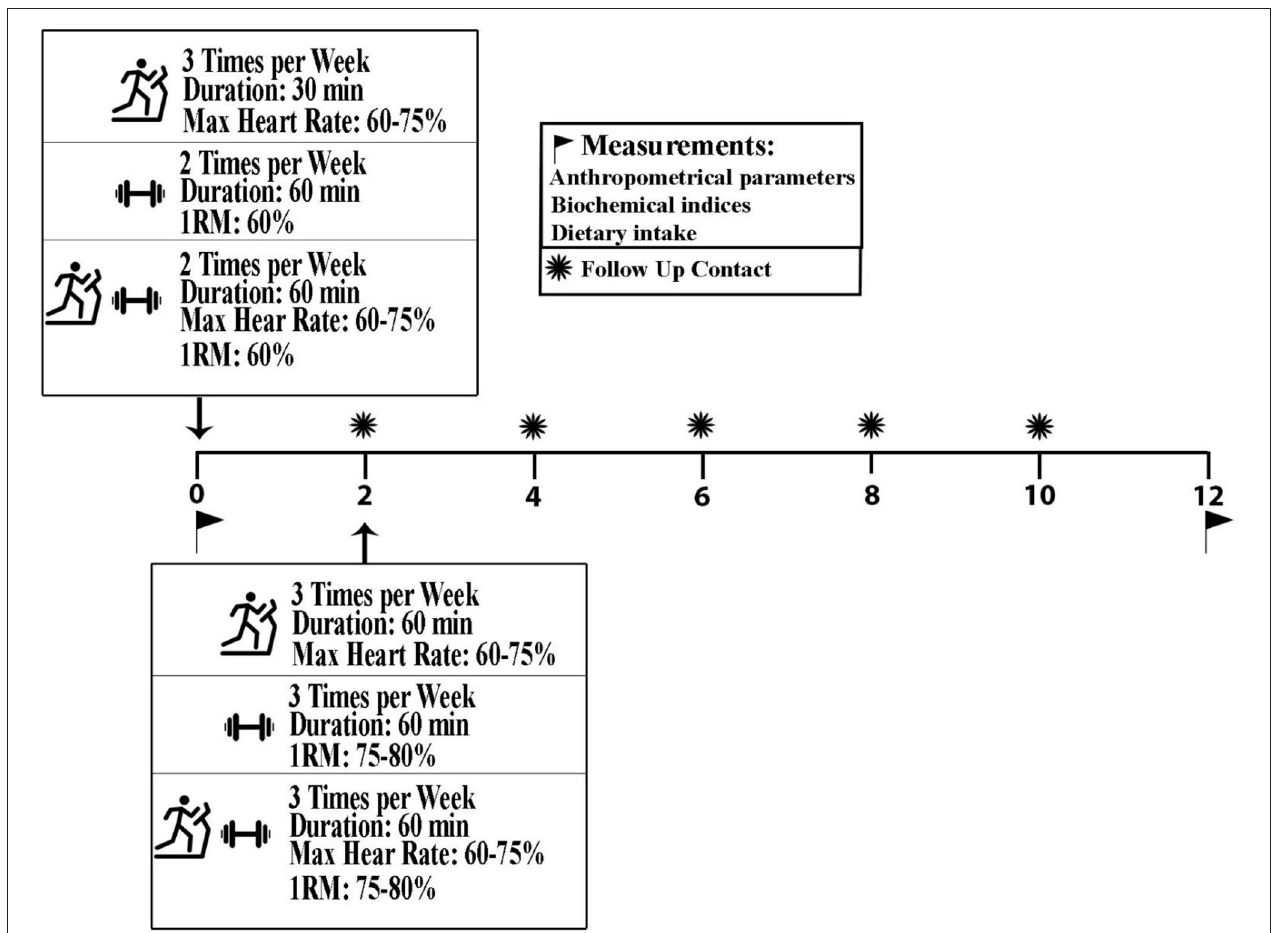
FIGURE 2 | An overview of the study